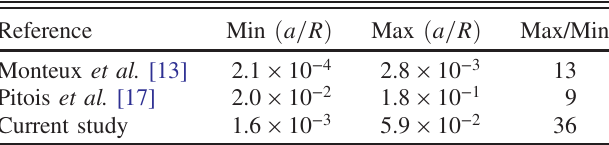
TABLE I. Range of particle diameter to bubble radius ratios ( a=R ) covered by the three studies.